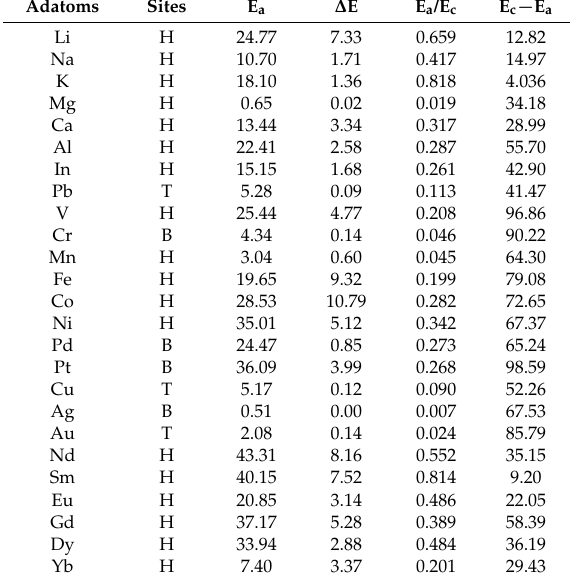
Figure 1. ( a ) Adsorption energy (E a ) and ( b ) diffusion barrier ( Δ E) for several adatoms on graphene as calculated by Liu et al. using density functional theory. Reproduced from Reference [100] with permission from the Royal Society of Chemistry. Table 1. E a (adsorption energy of the metal atom on graphene, kcal/mol), Δ E (diffusion barrier of the metal adatom on graphene, kcal/mol), E a /E c (with E c the bulk metal cohesive energy), and E c − E a (kcal/mol). Reproduced from Reference [100] with permission from the Royal Society of Chemistry. Adatoms Sites E